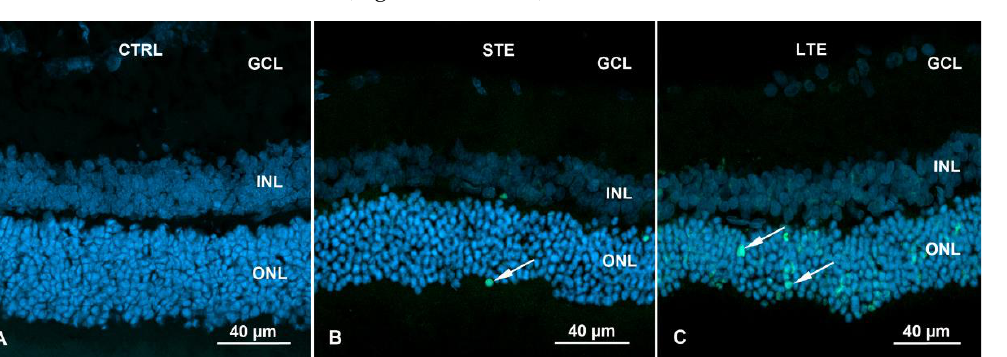
10 of 20 Figure 7. Effect of blue light on the intensity of glial fibrillary acid (GFAP) protein immunoreactivity